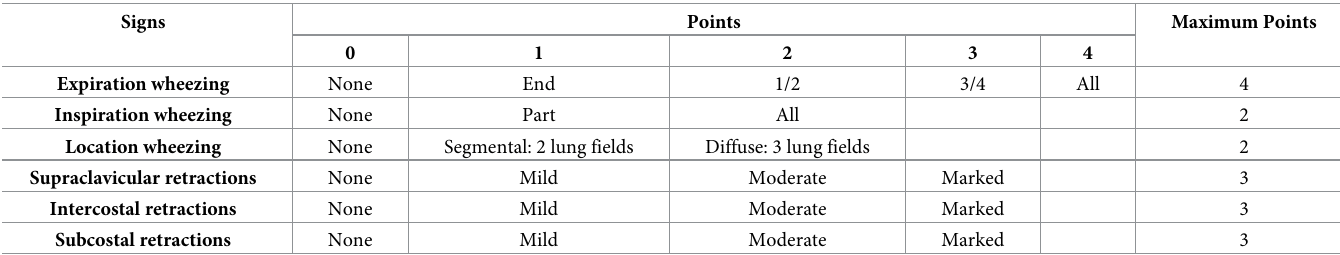
Table 1. Respiratory Distress Assessment Instrument (Lowell wheezing score, From